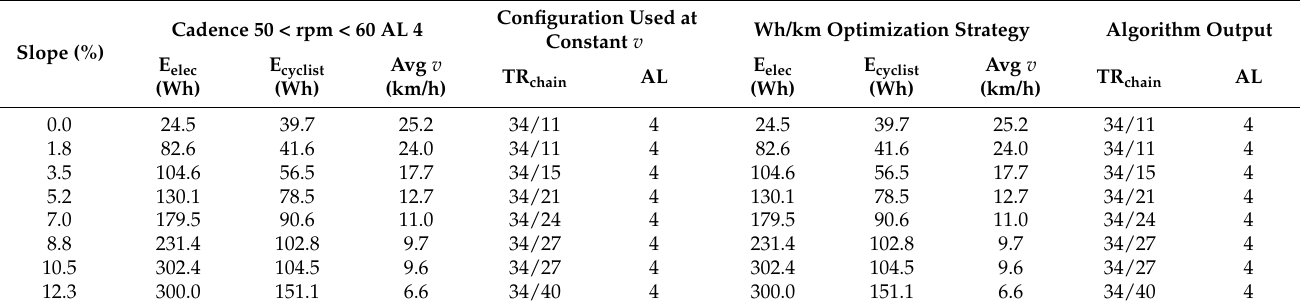
Table 5. Performance of strategies two and one under e-bike and human power (E stands for energy, v stands for speed, TR chain stands for chain transmission ratio and AL stands for assistance level). Slope